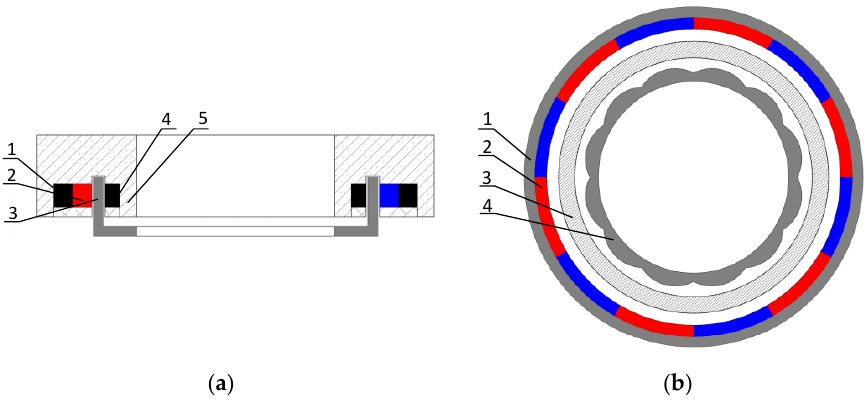
Figure 1. Model diagram of inner rotor’s eccentric hollow-cup motor: 1—Outer rotor; 2—PMs; 3—Cup stator; 4—Inner rotor; 5—Rotor fixing ring. ( a ) Axis section drawing of hollow-cup motor; ( b ) Top view of bow-shaped PMs’ hollow-cup motor.